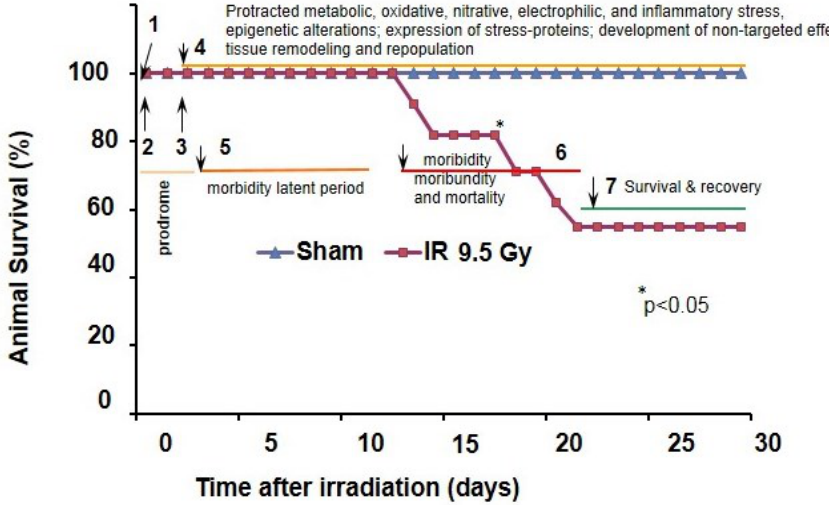
Figure 1. Kaplan–Meier survival plot and post-irradiation (post-IR) events in mouse model of the hematopoietic acute radiation syndrome (hARS). 1—Radiolysis due to pulse-irradiation and associated formation of (i) electrophilic and nucleophilic species; (ii) reactive oxygen and nitrogen species (ROS and RNS); (iii) electrophil-derived danger-associated molecular patterns (DAMPs), pro-inflammatory oxysterols,